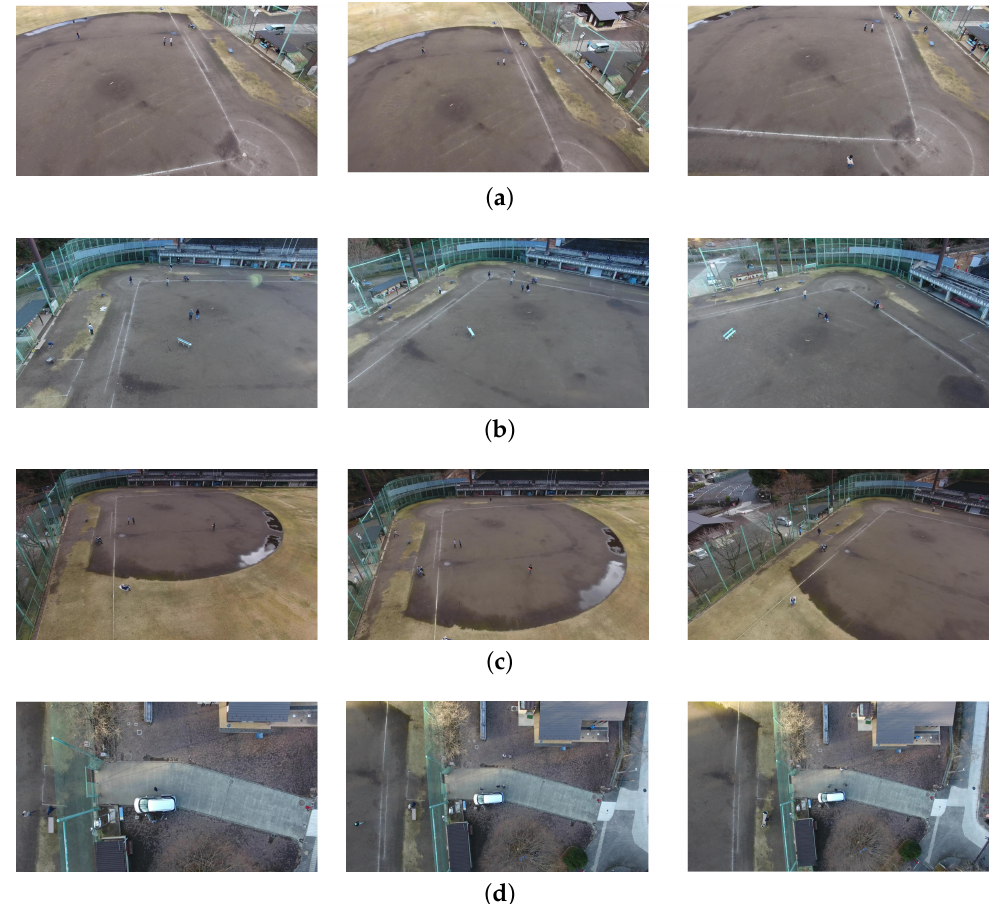
Figure 4. Some sample images from the Okutama-Action dataset. ( a ) Drone1, morning. Frame 1, 225, 2220 in video 1.1.1; ( b ) Drone1, noon. Frame 2, 270, 685 in video 1.2.2; ( c ) Drone2, morning. Frame 1, 200, 870 in video 2.1.1; ( d ) Drone2, noon. Frame 175, 325, 700 in video 2.2.5. In this setting, camera